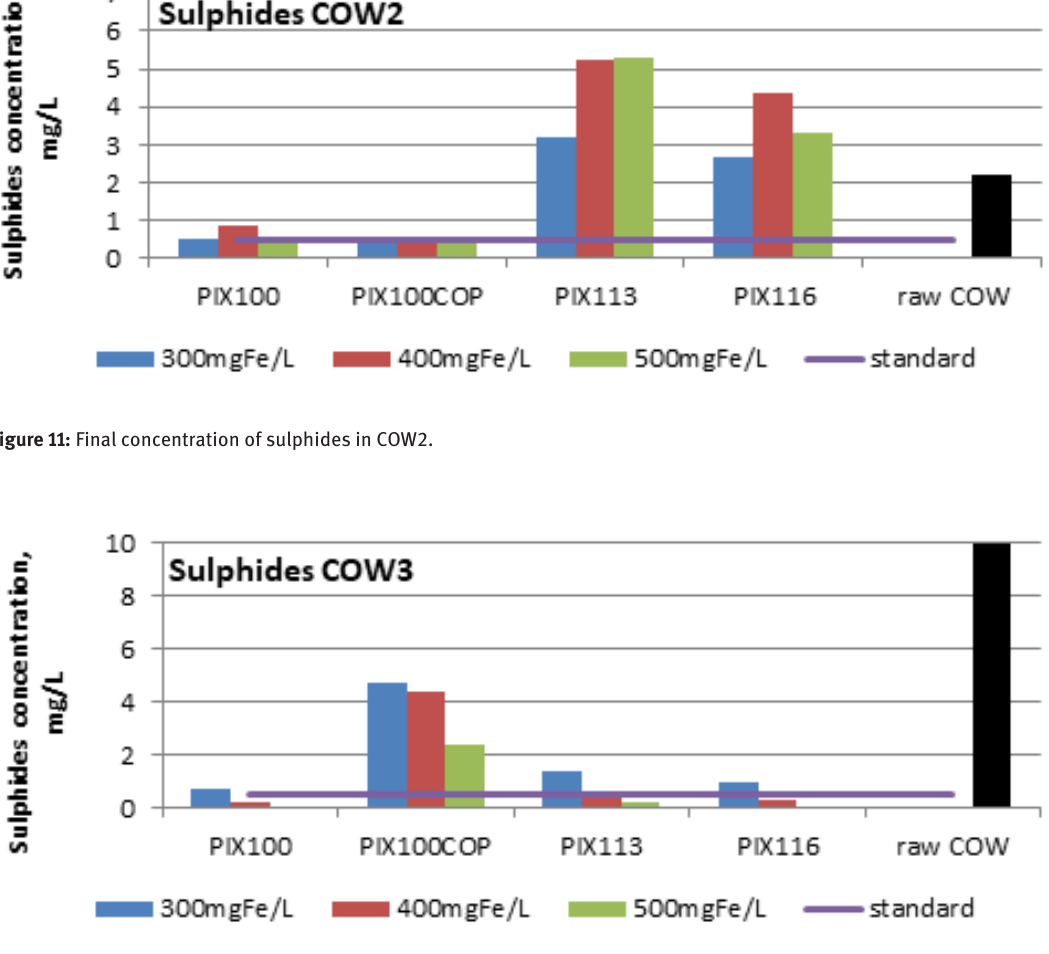
Figure 12: Final concentration of sulphides in